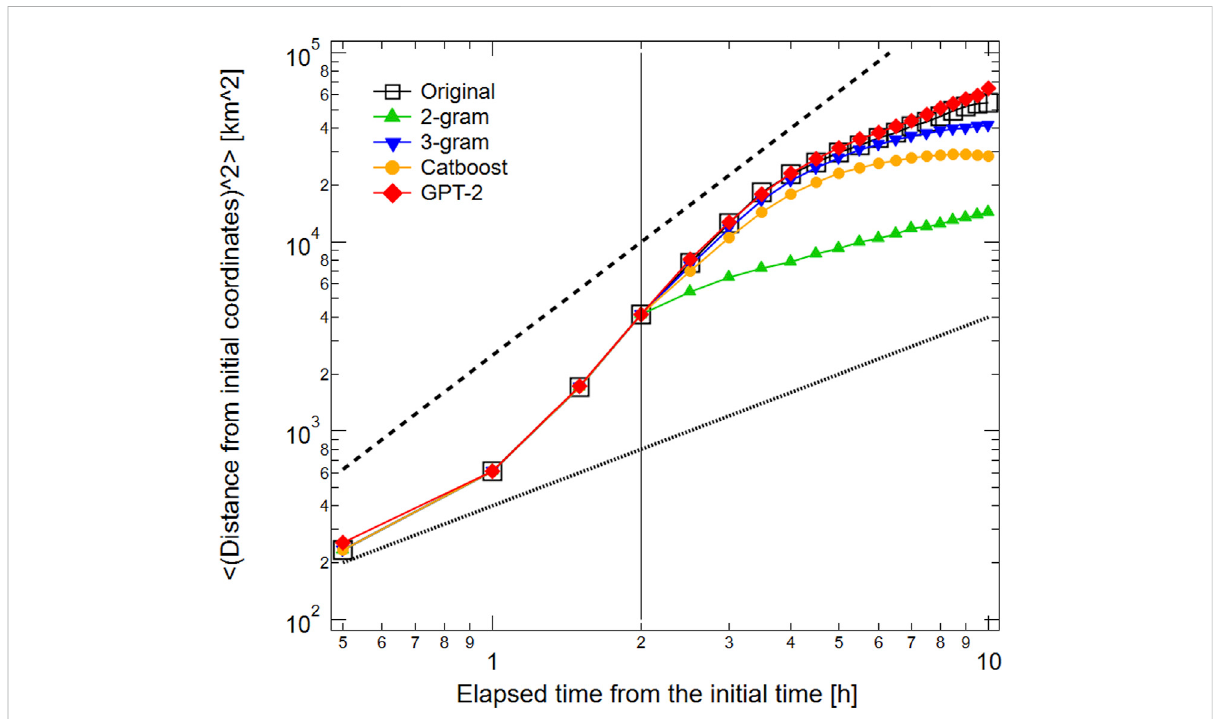
(cid:129) ) Multi-Output Catboost, and ( A ) GPT-2 models.